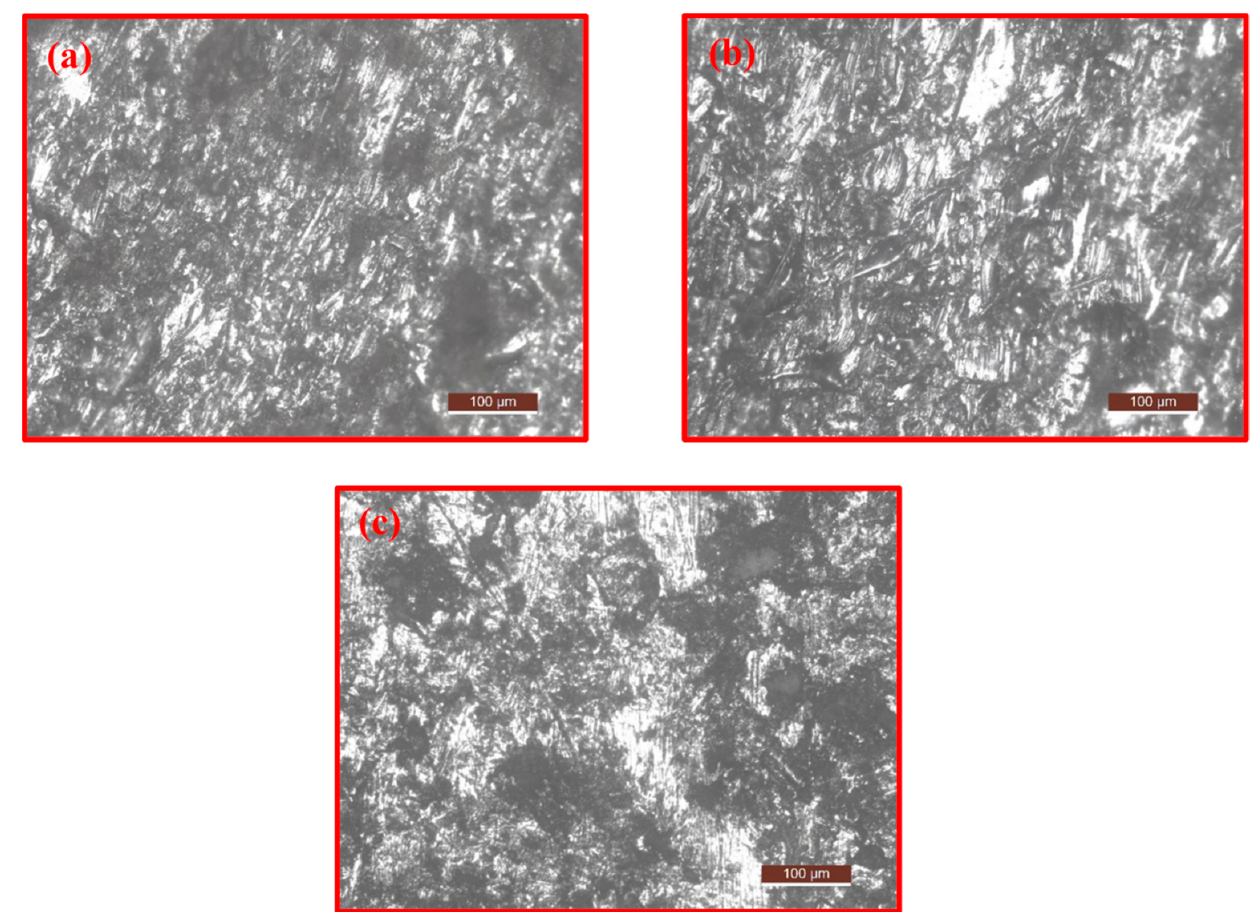
Figure 8. Fracture surface optical micrograph ( a ) base metal, ( b ) weldment-1, ( c ) weldment-2.